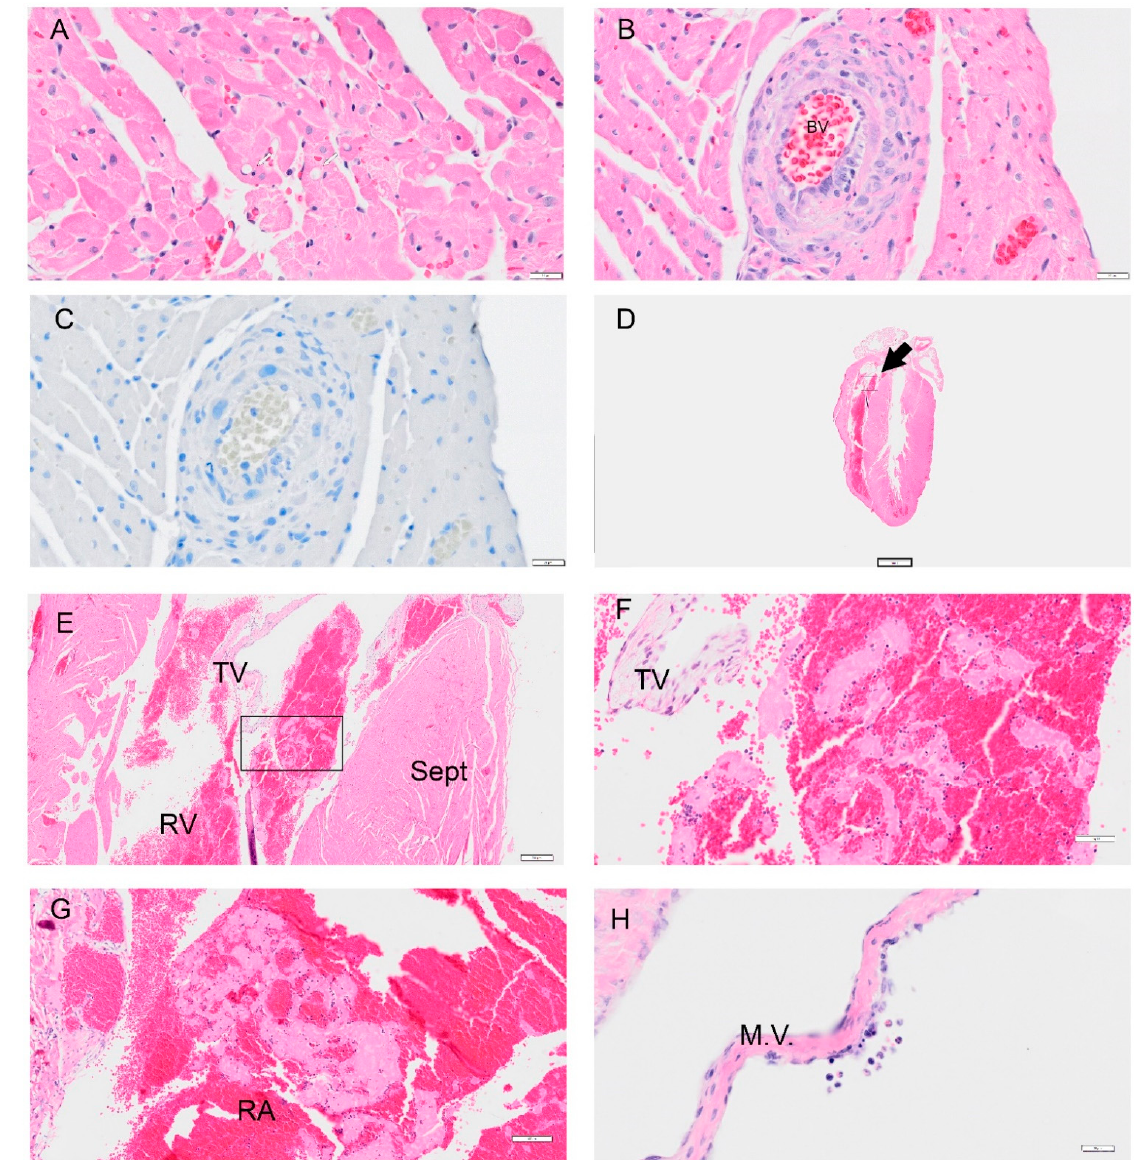
Figure 10. Selected pathology and immunohistochemistry of the heart from the Syrian hamster following infection with SARS-CoV-2. Representative images of pathology are presented. ( A ) An image at 1 dpi from the right ventricle showed mild degeneration of cardiomyocytes. ( B ) An image from 1 dpi shows an abnormal muscle layer in the coronary artery. ( C ) A representative image of the heart probed for viral antigen by IHC Viral N protein was not detected in over 80 slides. ( D ) A low magnification image of the heart at 8 dpi in a female hamster with an arrow showing a thrombus (0.4 × ). ( E ) An image of a right ventricle with a platelet and fibrin aggregate (4 × ). ( F ) Higher magnification of ( E ) which in the right ventricle with white blood cells (WBC) trapped in fibrin and red blood cells (RBC); close to the tricuspid valve (TV). ( G ) An image showing a thrombus in the right atrium (RA) with similar findings in the right ventricle in ( F ). ( H ) Image showing endothelial cell abnormality with hyperplasia of the endothelial cells. Image shows WBC (mononuclear cells and eosinophils) around a damaged area on the mitral valve (M.V.) (female 8 dpi). Abbreviations: RV: right ventricle; Sept: septum; TV: tricuspid valve. Scalebar: ( A – C , H ) = 20 µ m; ( D ): = 2 mm, ( E ) = 200 µ m; ( F ) = 50 µ m, ( G ) = 100 µ